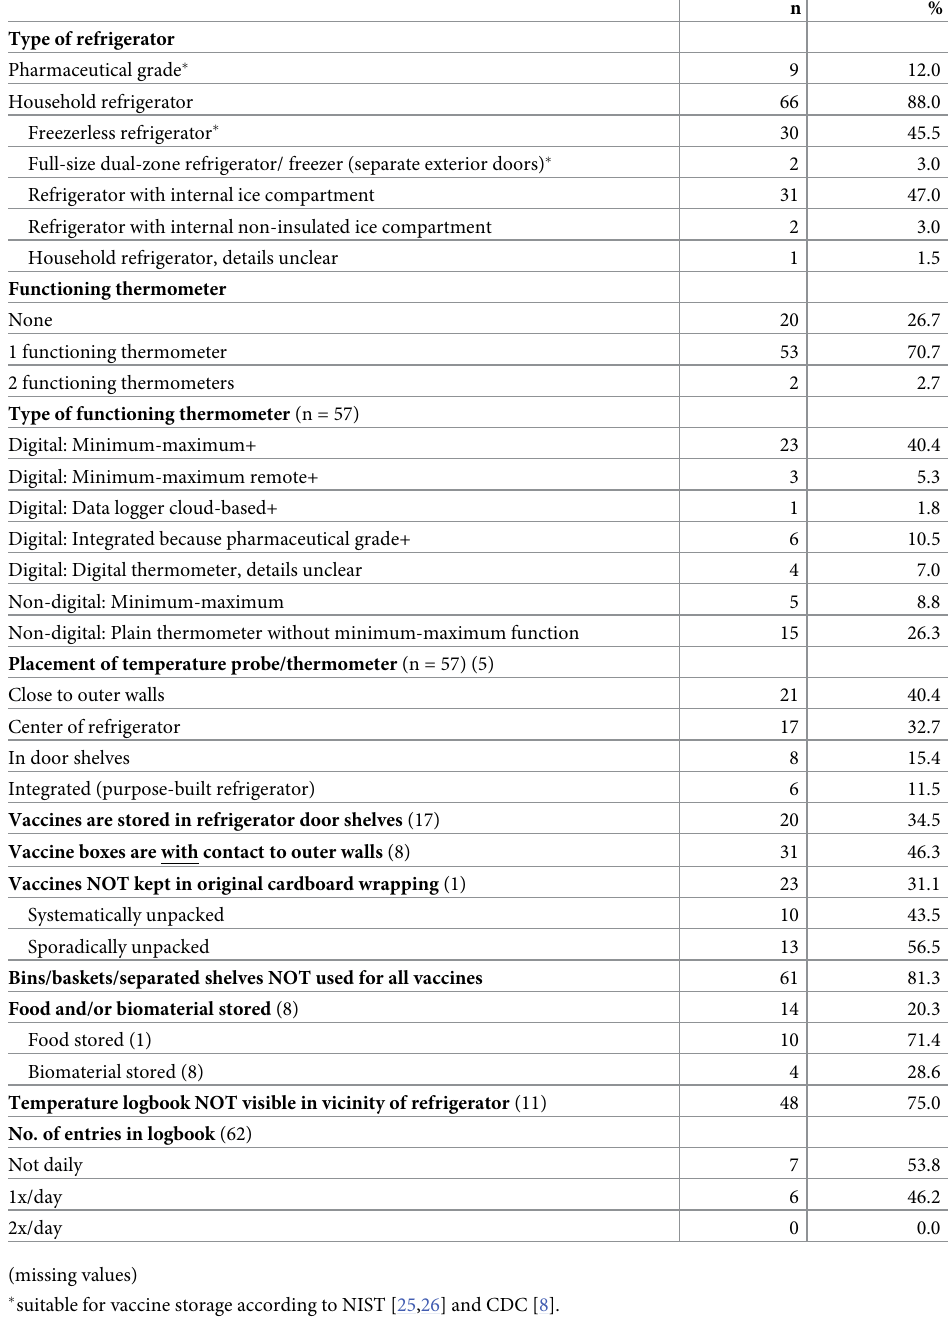
Table 3. Visual inspection of refrigerators used for vaccine storage based on (N =